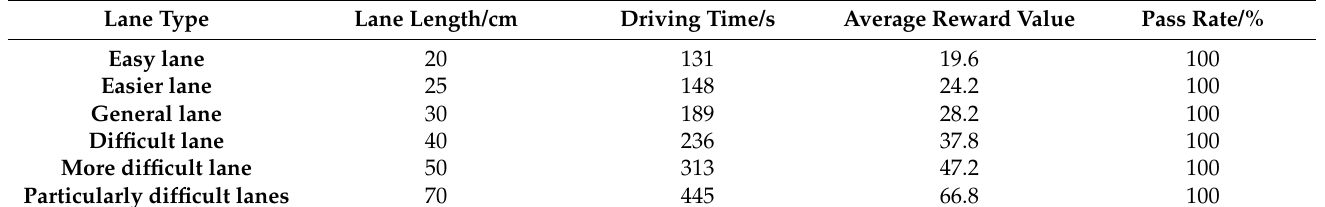
Figure 13. Different types of verification lanes. ( a ) is an easy lane type, ( b ) is a relatively easy lane type, ( c ) is a common lane type, ( d ) is a difficult lane type, ( e ) is a relatively difficult lane type, and ( f ) is a particularly difficult lane type. Table 4. Experiment on generalization performance of virtual vehicle autonomous driving under different road conditions.